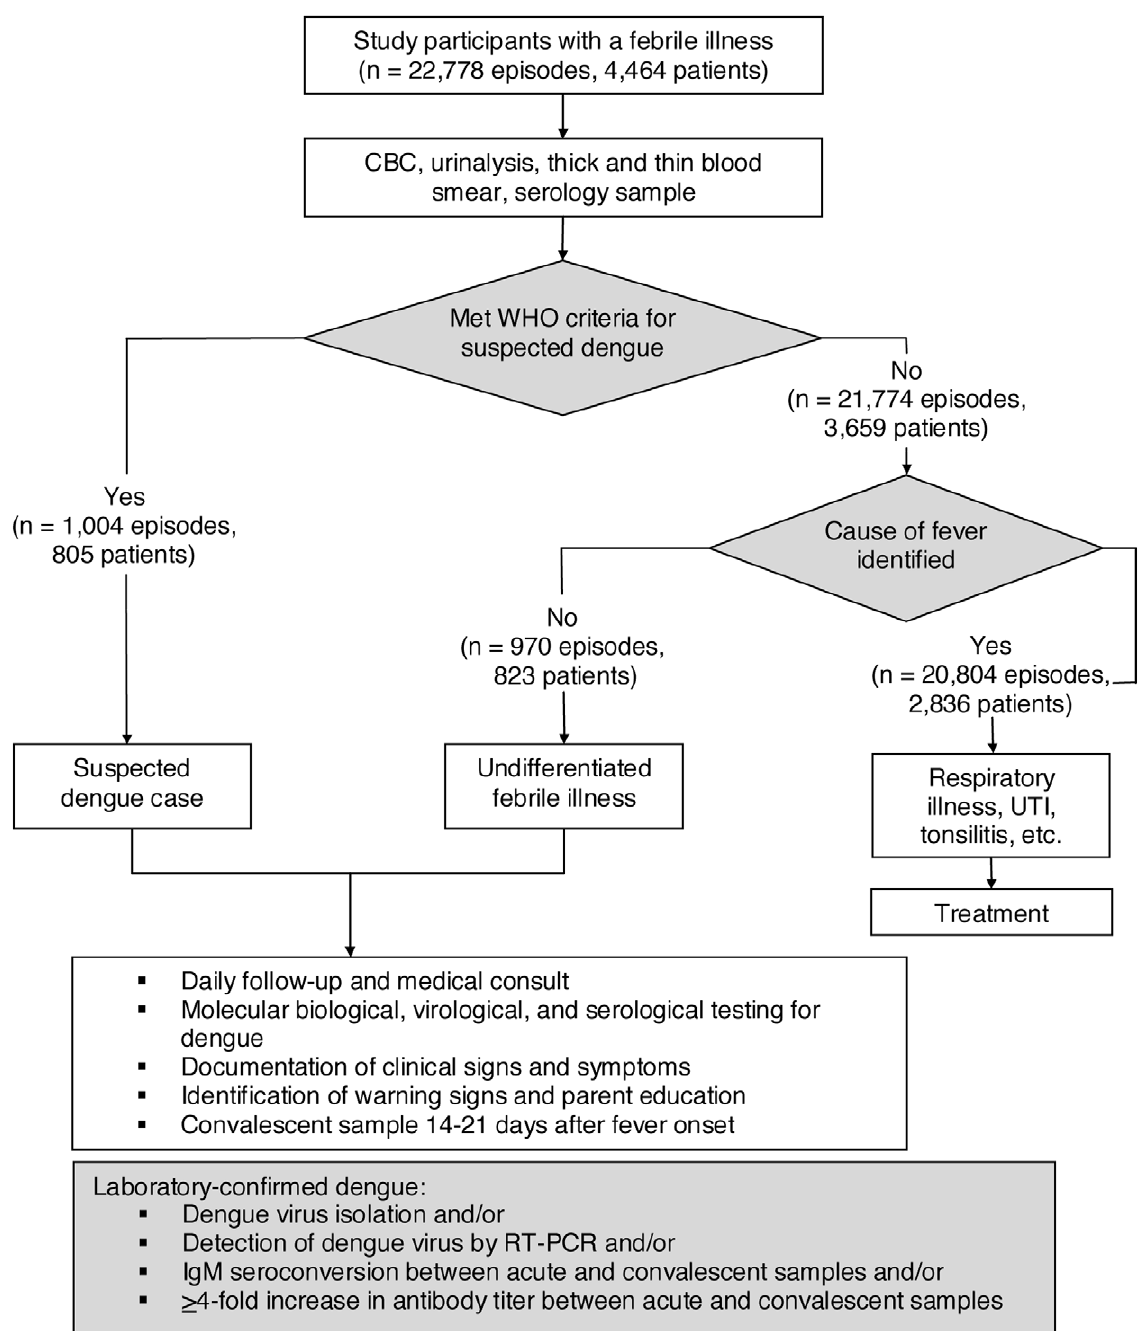
Figure 1. Flowchart of clinical and laboratory protocols for study participants in the Pediatric Dengue Cohort Study. Of the 1,974 episodes of febrile illness in the Pediatric Dengue Cohort Study from August 2004 to June 2009 that met the WHO classification criteria for suspected dengue or were diagnosed with undifferentiated fever, 405 patients presented with febrile illness on 2 occasions, 105 presented on 3 occasions, 21 presented on 4 occasions, and 5 presented on 5 occasions. One patient presented after day 8 of illness and was excluded from analysis. Twenty-nine patients had cause of fever identified later in the course of illness. CBC, complete blood count; WHO, World Health Organization; UTI, urinary tract infection.